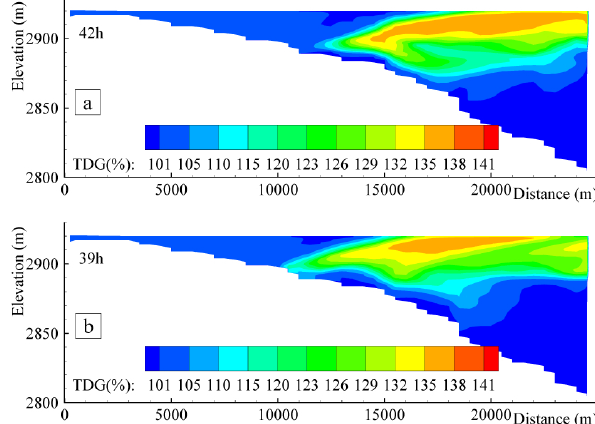
Fig. 12. Comparison of TDG distributions at the moment of accu- mulated off-time of 24h ( a Case 1; b Case